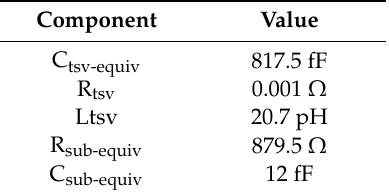
Table 2. Lumped circuit elements of TSV–active circuit noise coupling.